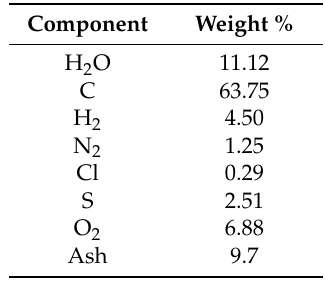
Table 1. Ultimate Analysis of Coal Feed to the